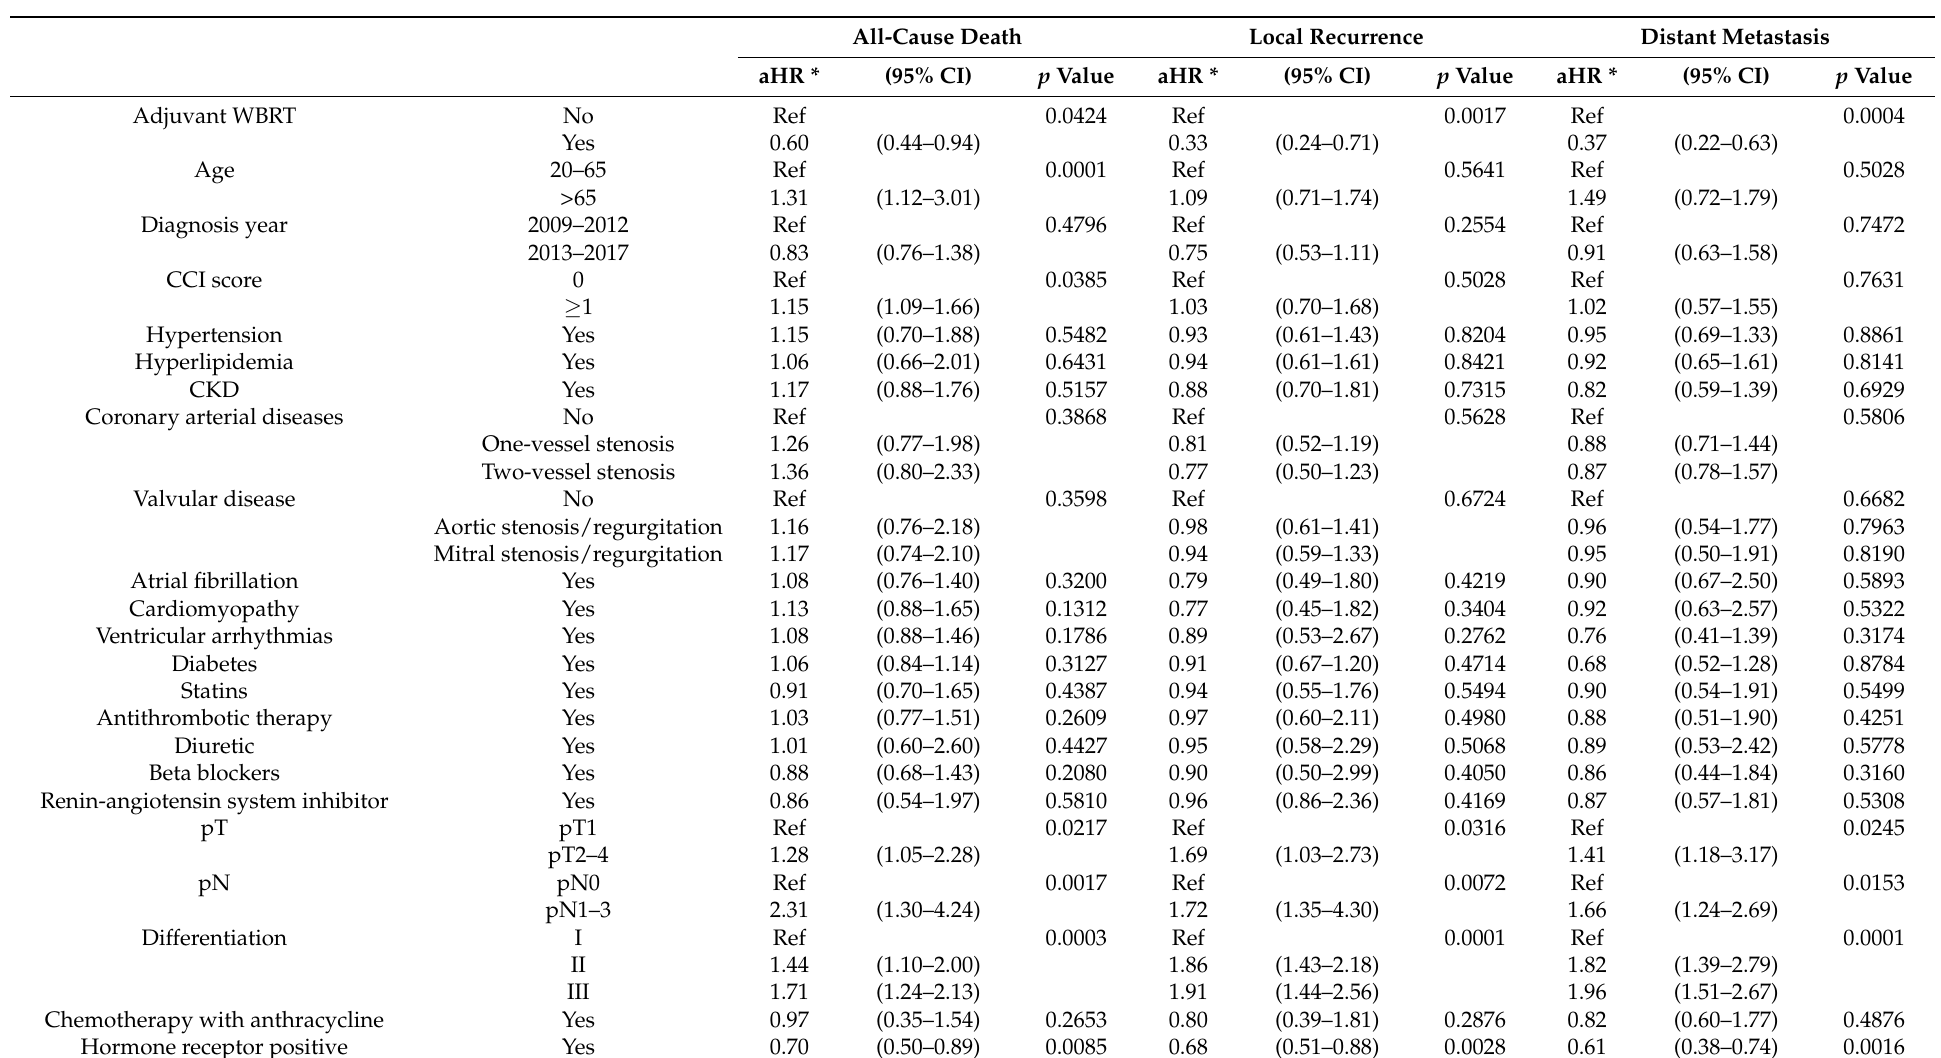
Table 2. Multivariate analysis of propensity score–weighted population with breast cancer and heart failure with reduced ejection fraction receiving breast conservative